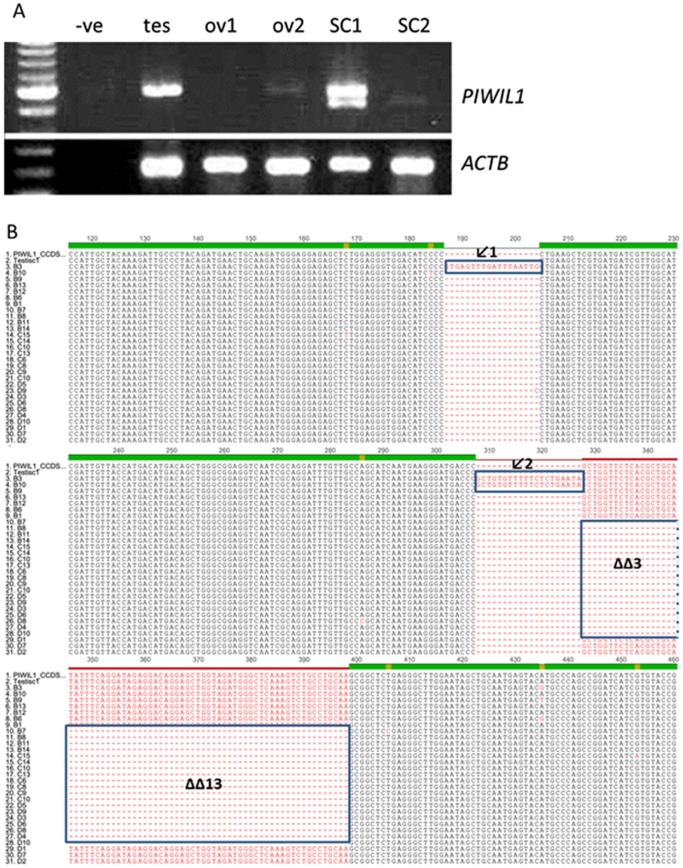

PIWIL1 transcript variants in EOC.(A) PIWIL1 expression in control tissues (human testis, normal ovary (ov) 1, 2) and EOC tissue SC1 and 2. In the positive control, a 500 bp band was amplified, but in malignant SC1, two bands were obtained. (B) cDNA multiple alignment (partial) showing that most of the clones have a deletion of exon 17 (ΔΔ3) and 3 clones have partial splicing of intron 15 and 16 (). PIWIL1_ccds: published cDNA of PIWIL1 (CCDS9268); Testis C1: testis transcript clone 1; B1–3, B6, B9–B14, C6, C8, C9, C10–C15, D1–D10: clones with PIWIL1 transcripts.